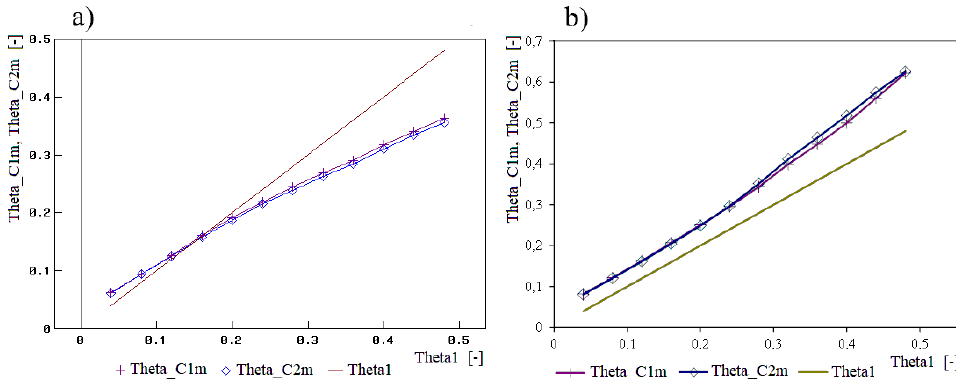
Figure 8: Values of diagnostic parameters ϑ C 1 m (Theta_C1m) and ϑ C 2 m (Theta_C2m) as functions of the dimensionless coeflcient of damp- ing in the suspension system ϑ 1 (Theta1), obtained from an analysis of the factor of gain in the force measured by the real diagnostic tester, i.e. under the exciter (relative to the input force), close to the second natural frequency of the front “quarter car”: a) results for the linear model; b) results for the nonlinear model